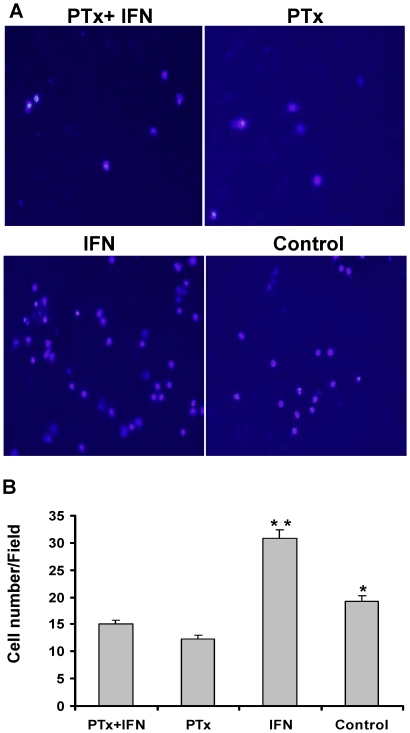
PTx significantly reduced migration of stimulated microglia.Microglia migration was quantified and compared among the groups by counting the number of cells that migrated through the membrane to the lower chamber. Five random fields at 40X fields were counted for each condition under a phase contrast microscope. Results were shown as the cells counted per 40X field (A and B). In PTx treated groups, cell migration was significantly reduced. * p<0.05 compared with PTx; * * p<0.01, Compared with PTx+ IFN, PTx and Control groups.